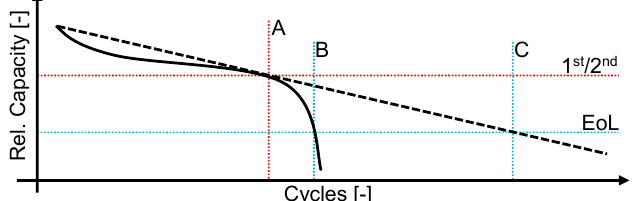
Figure 1. Schematic display of capacity retention, for linear (dashed) ageing and non-linear (solid) ageing behavior with sudden-death. In red, the residual capacity based transition between first- and second-life (1st/2nd) and the corresponding cycle count A is displayed. Based on an end-of-life (EoL)-criterion, point B and C represent the EoL for the non-linear and linear ageing